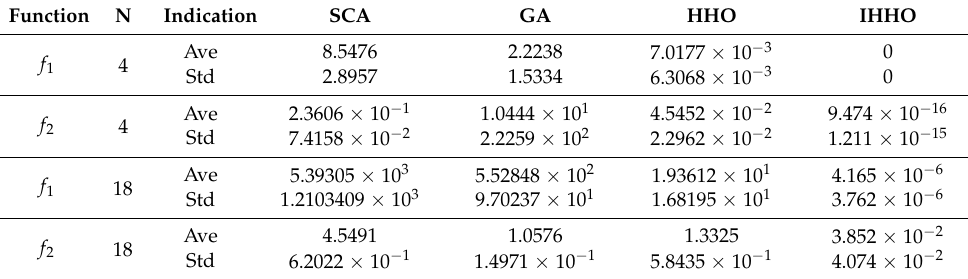
Table 2. Comparison of the test function optimization